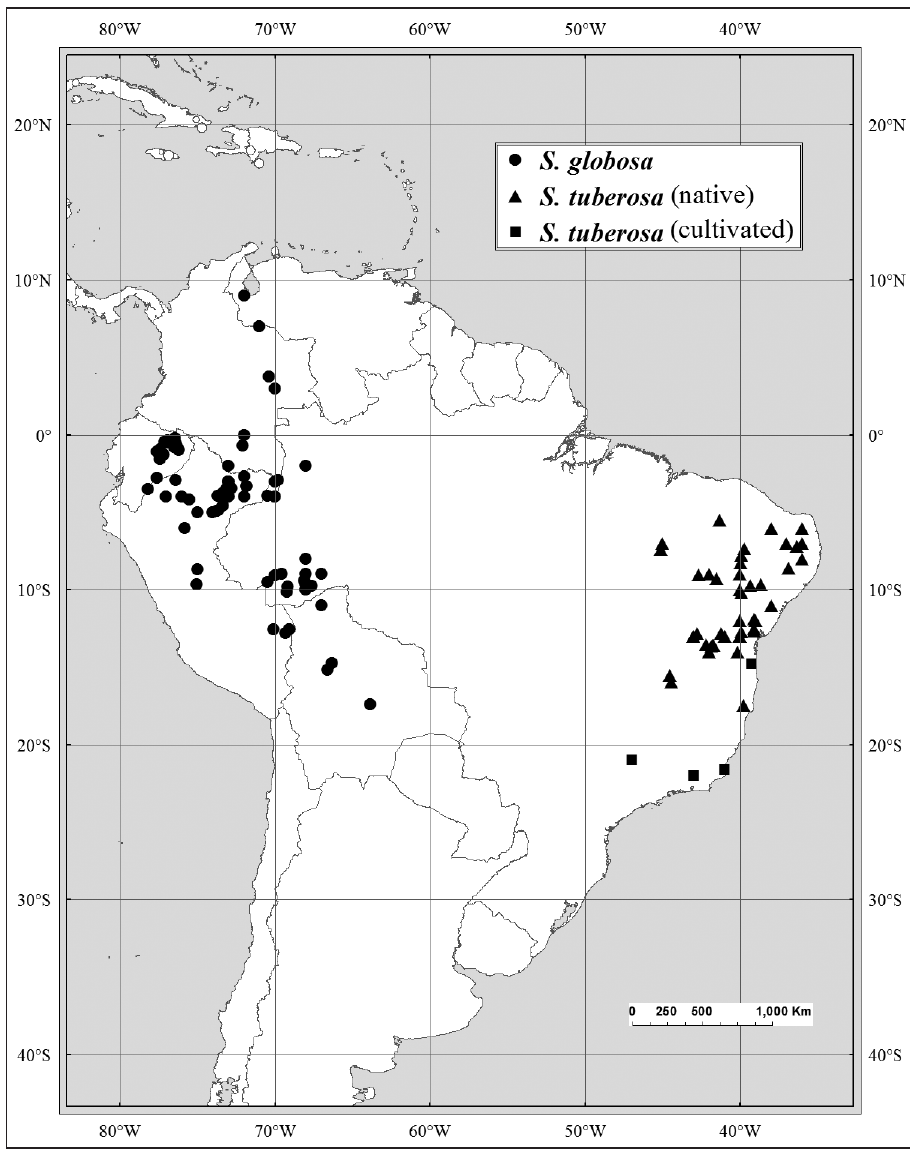
Figure 13. Distributions of S. globosa and S.